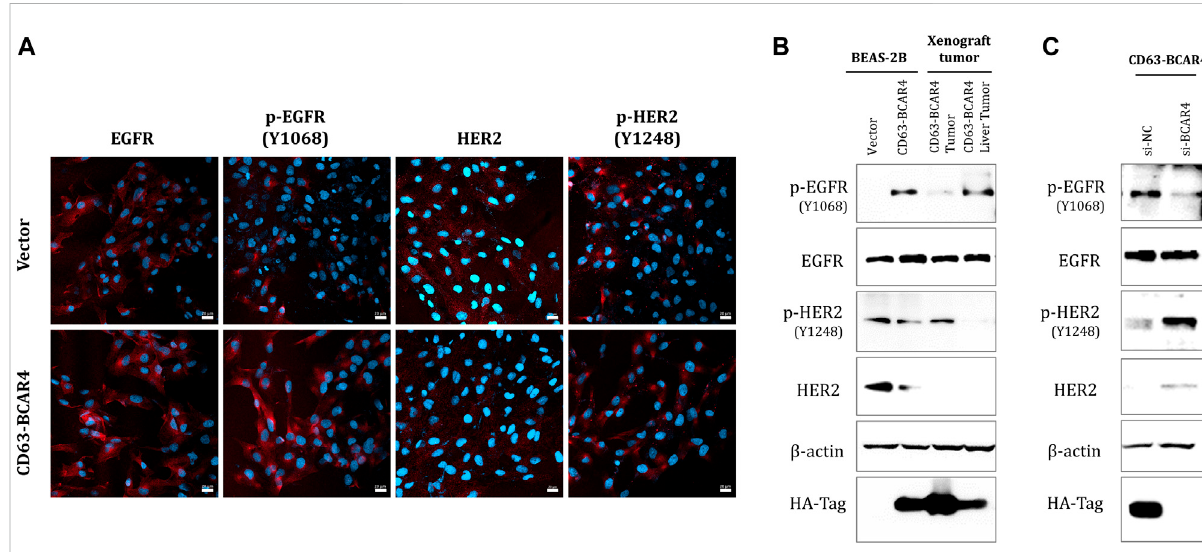
FIGURE 2 Expression of EGFR and HER2 proteins in CD63-BCAR4 overexpressed cells. (A) EGFR, p-EGFR(Y1068), HER2, p-HER2 (Y1248) (red) and Hoechst 33,342 (blue) nuclear staining in CD63-BCAR4 overexpressing cells were determined using immunocytochemistry. (B) Western blot showing protein levels in overexpressed cells, tumors, and metastatic liver tumors from xenograft mice. (C) Protein expression level in cells was evaluated by transfection of siRNA targeting BCAR4 (si-BCAR4) and a negative control